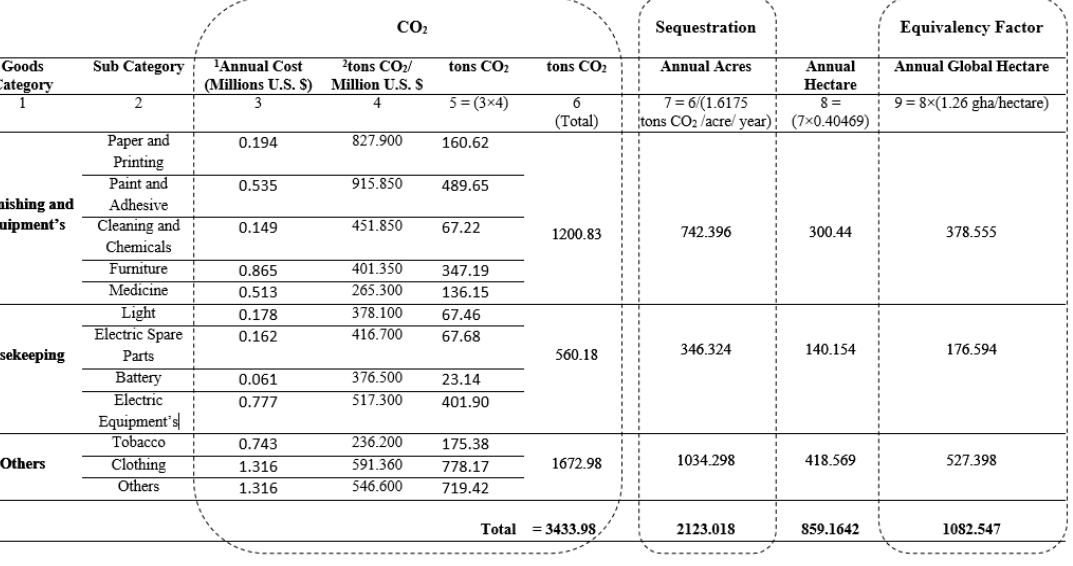
Figure 12. Goods consumption footprint calculation and derivation. Source: 1 Household survey of Ward 24 RA (2015); 2 GHG emissions; EIO-LCA (2015).